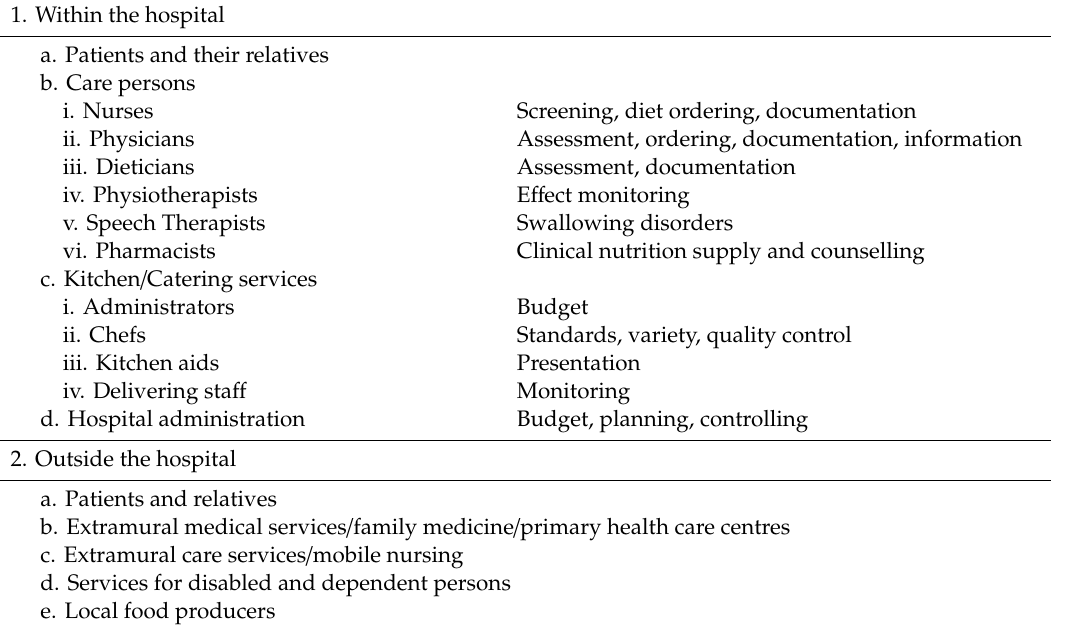
Table 1. List and role of important